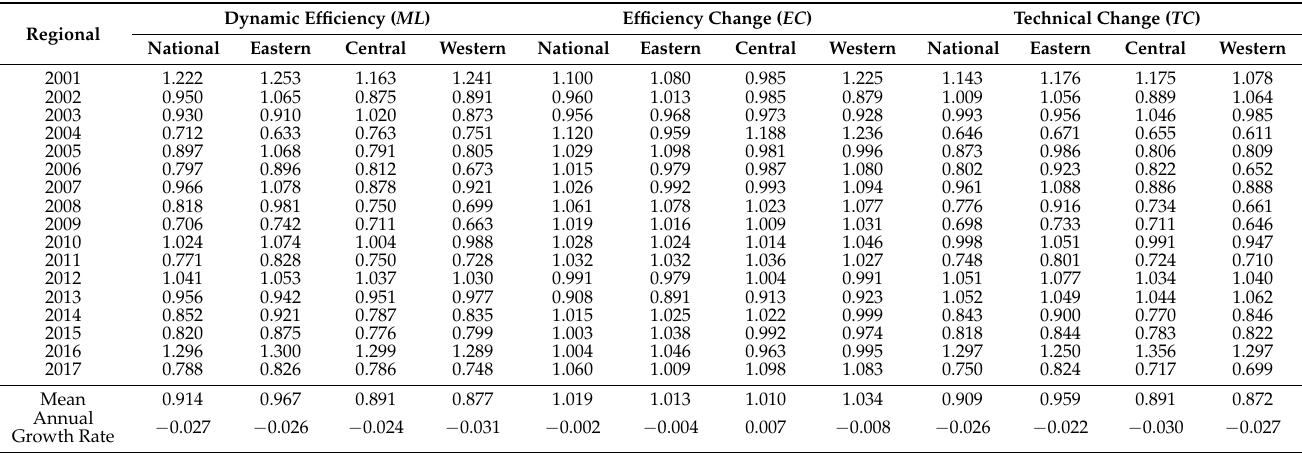
Table 3. The Dynamic